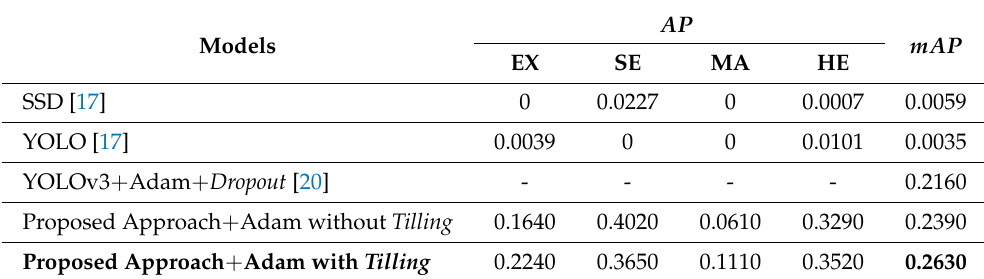
Table 6. Results obtained by the proposed approach with Adam optimizer compared to works related to the metrics AP and mAP for the Intersection over Union limit of 0.5 in the validation set of the Dataset for Diabetic Retinopathy